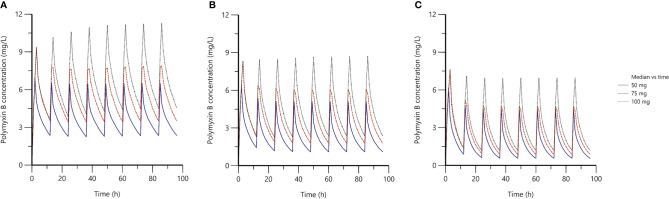
The median simulated plasma concentration-time profiles based on the final population PK model. (A) the creatinine clearance (CrCL) of 31.3 ml/min; (B) the CrCL of 105.9 ml/min; (C) the CrCL of 315.2 ml/min; the blue solid lines represented 100 mg loading dose with 50 mg maintenance dose twice daily; the red dash solid lines represented 150 mg loading dose with 75 mg maintenance dose twice daily; the black dot lines represented 150 mg loading dose with 100 mg maintenance dose twice daily.